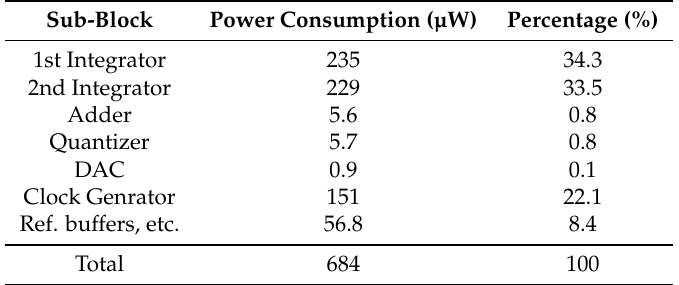
Table 2. Power consumption breakdown.